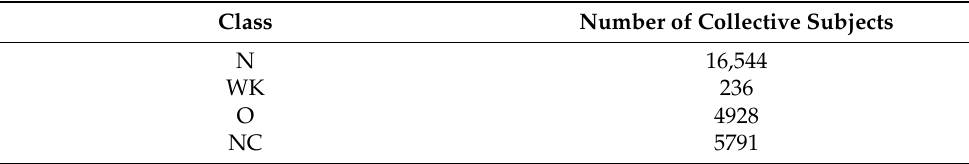
Table 1. Distribution of collective subjects by classes.